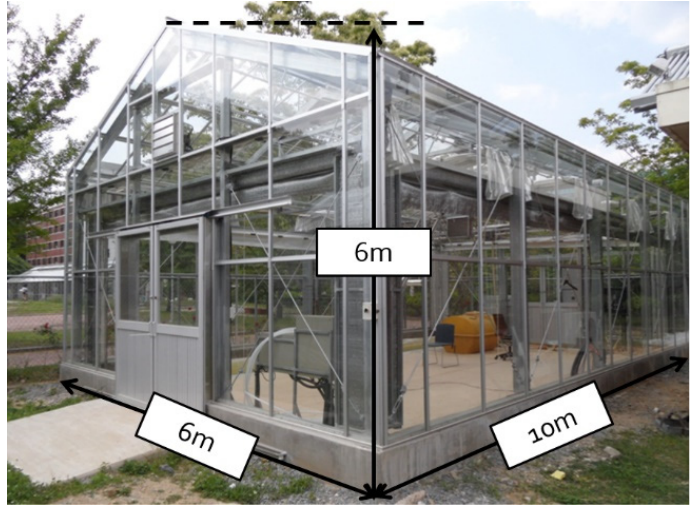
Figure 4. Experimental glass greenhouse used for the study with their respective dimensions.